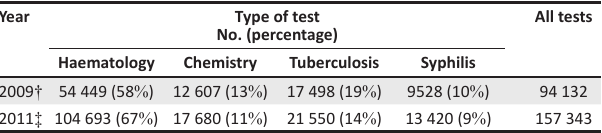
TABLE 2: Tests conducted by PEPFAR-supported laboratories in 2009 and 2011 by type of test Year Type of test No. (percentage)